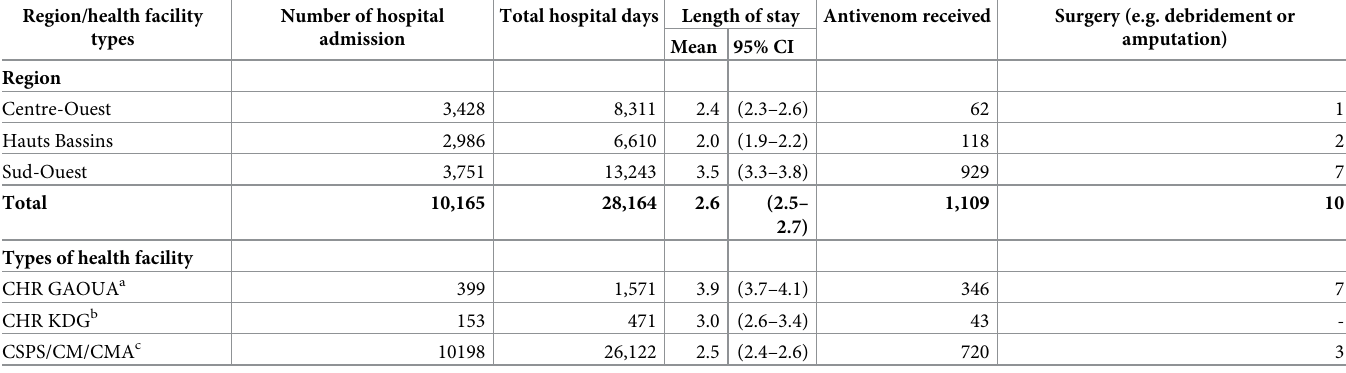
Table 4. Health service utilisation for snake envenoming by region and type of health facility (17 months